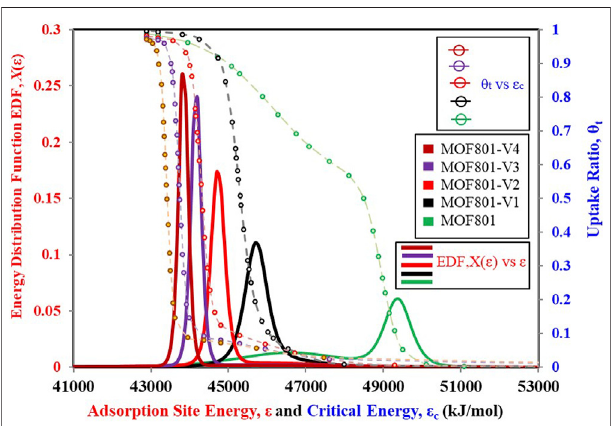
FIGURE 3 | Energy distribution function (EDF) curves for MOF 801 and variants.